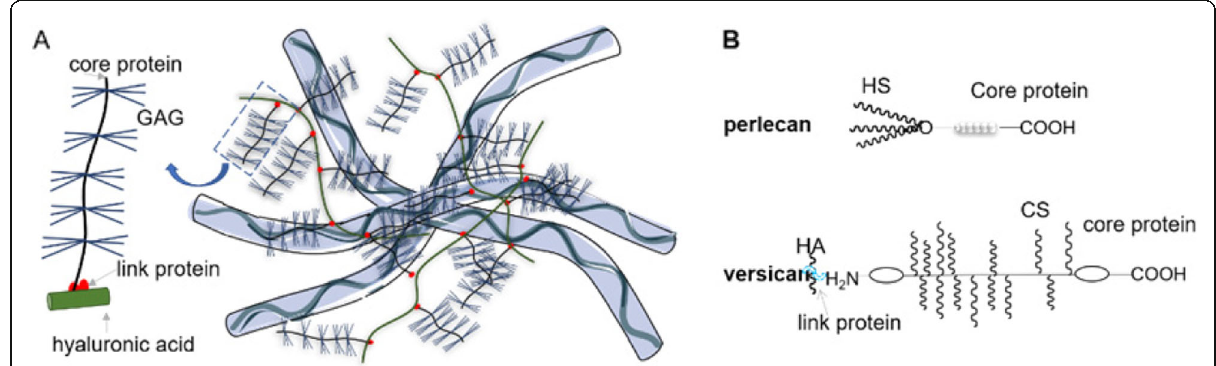
Fig. 8 The schematic of large aggregated proteoglycans. a The structure and existing ways of large aggregated proteoglycans in collagen bundles; b The structure of the main large aggregated proteoglycans, perlecan and